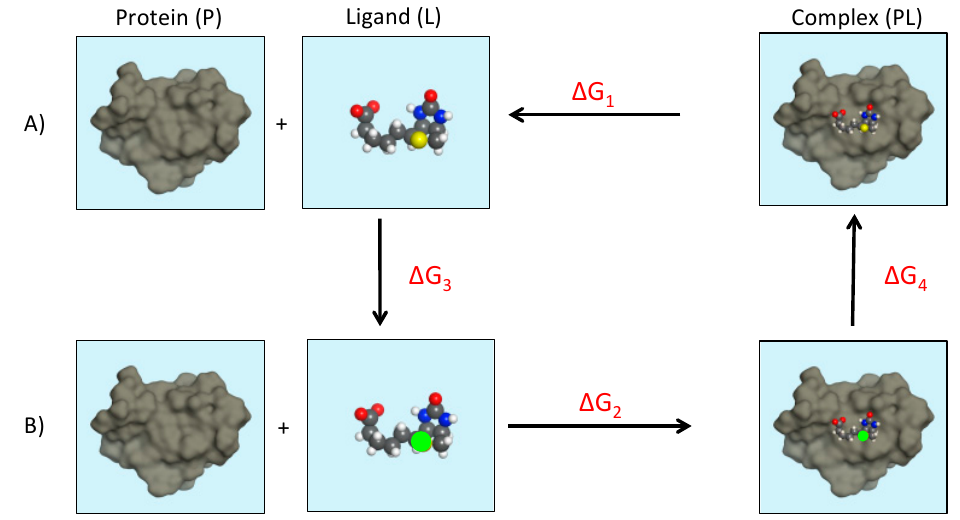
Figure 9. Schematic representation of a thermodynamic cycle to calculate the relative binding free energy upon a ligand modification. The binding free energy of the ligand or protein in state A ( Δ G1) and that in state B ( Δ G2) are the physical binding processes that need to be determined, whereas ( Δ G3) and ( Δ G4) (the vertical legs) indicate the unphysical transformation of ligand A (yellow) to ligand B (green). However, ( Δ G3) and ( Δ G4) values are more accessible to the free energy perturbation methods. According to the conservation of energy, we can derive ( ΔΔ G = Δ G2 − Δ G1 = Δ G4 − Δ G3).